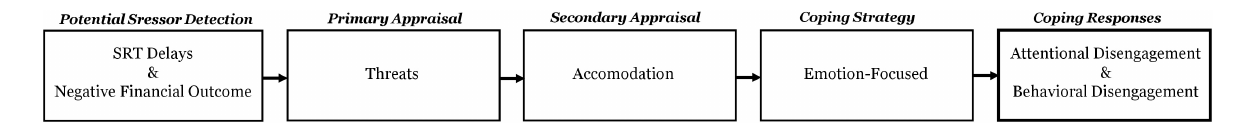
FIGURE 1 | The stress-coping transactional model, applied to digital financial technology